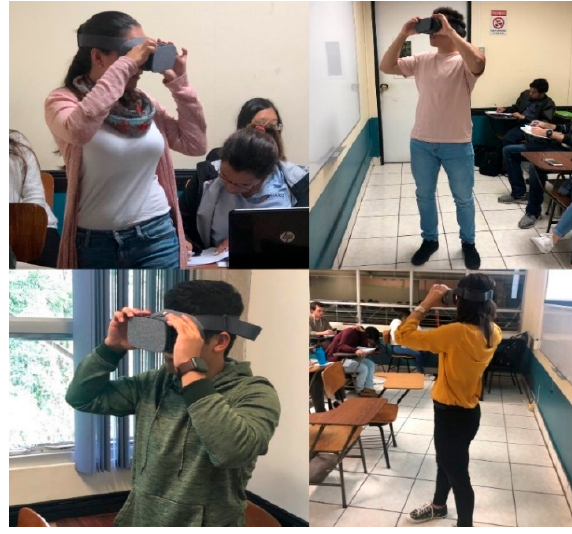
Figure 6. Prototype